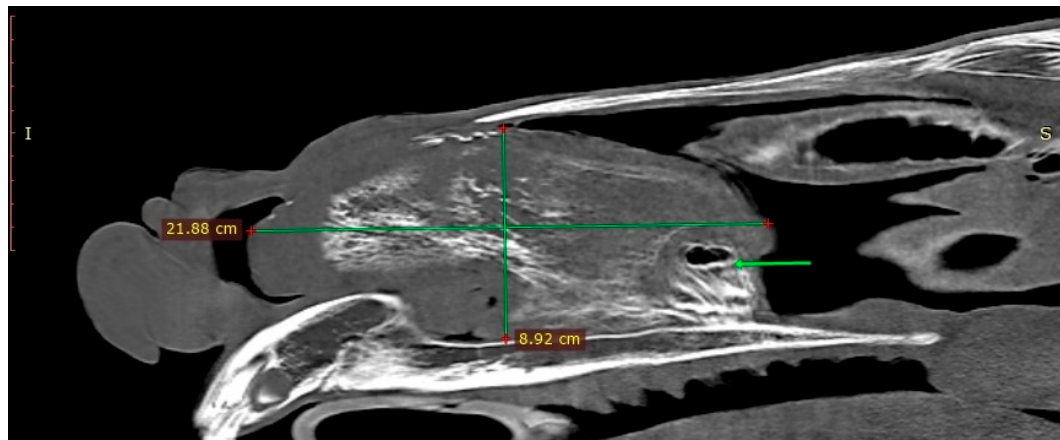
Figure 3. Sagittal CT image obtained left to sagittal line (bone algorithm, WW1500, WL 300). The mass length × height are indicated with green lines. Connection between the mass and the Triadan 208 is present (green arrow).